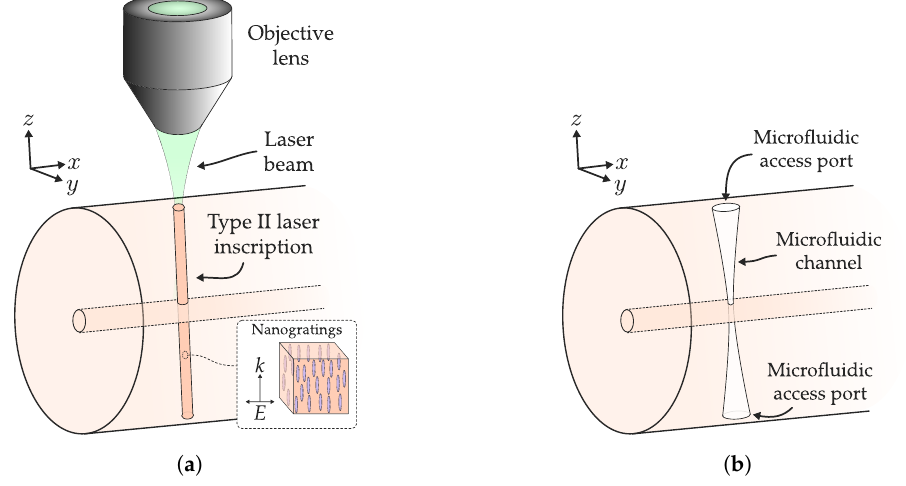
Figure 2. Illustrative diagram of the formation of microchannels in fused silica (optical fiber) using the femtosecond laser irradiation followed by chemical etching (FLICE) technique. ( a ) Step 1: Permanent Type II modification in the sample by non-linear absorption of focused femtosecond laser